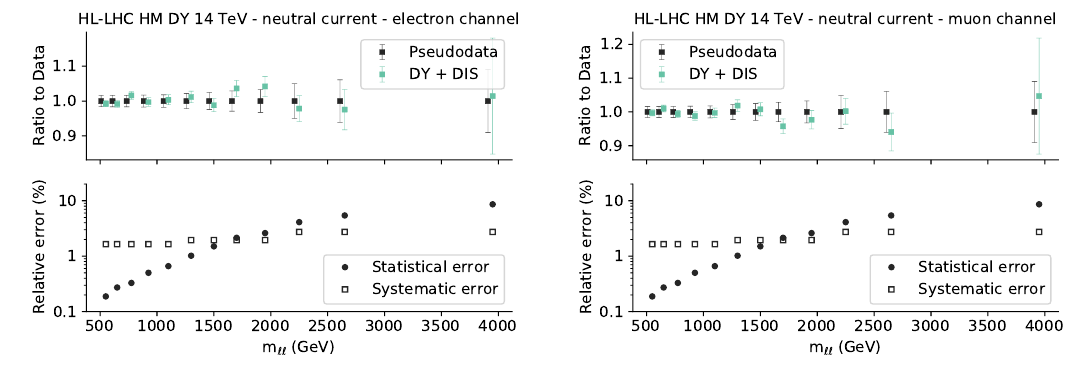
Figure 12 . Top panels: comparison of the projected HL-LHC pseudo-data for high-mass neutral- current Drell-Yan in the dielectron (left) and dimuon (right) final states as a function of m ‘‘ with the corresponding theory predictions obtained from the SM PDF baseline. The theoretical predictions, generated according to eq. (5.3), are accompanied by their corresponding PDF uncertainties (green bars). Lower panels: the percentage statistical and systematic uncertainty in each m ‘‘ bin of the HL-LHC pseudo-data.